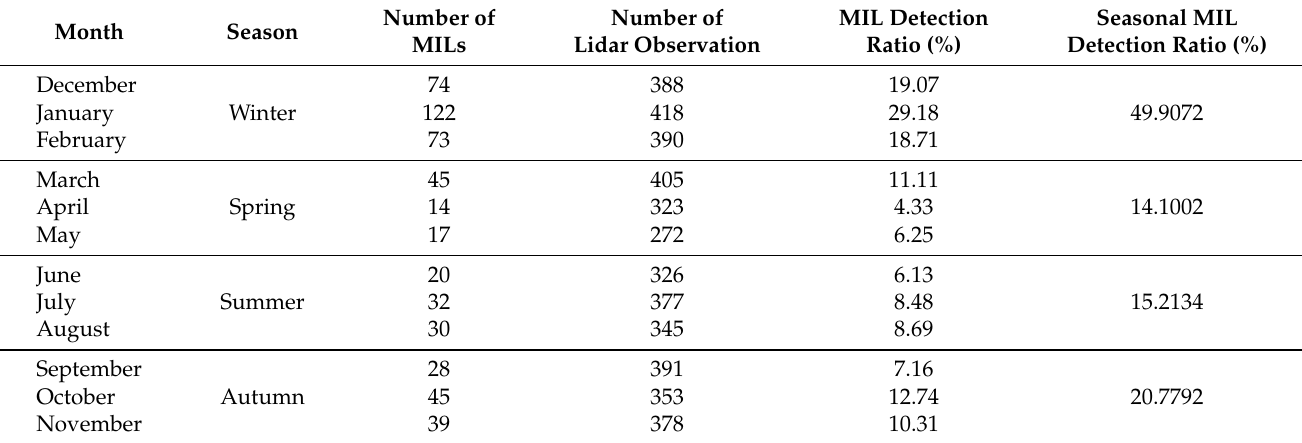
Table 2. Distribution of MIL measurements by month,